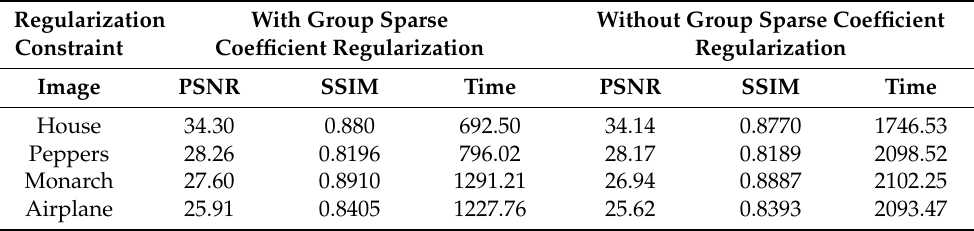
Table 1. The results of the model with and without group sparse coefficient regularization.